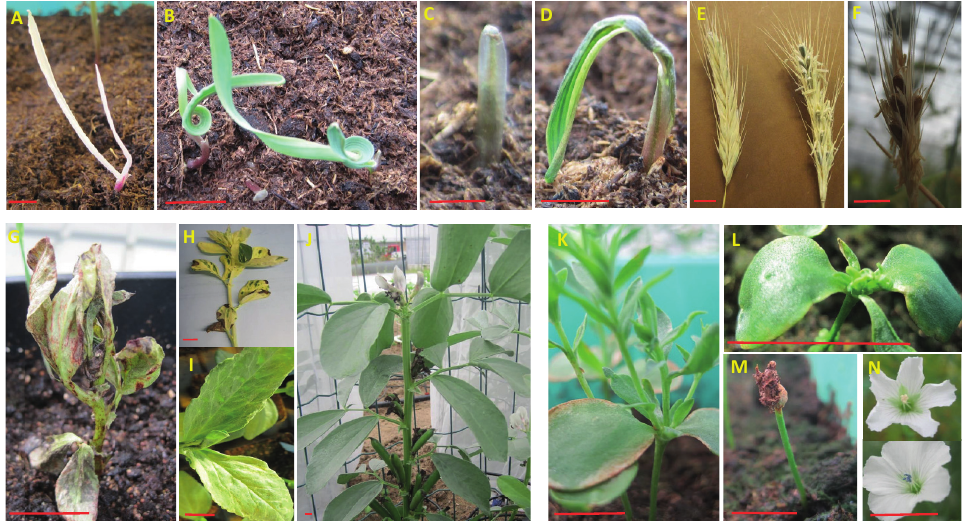
Fig. 3. Variation in phenotypes of M and M seedlings produced by ion beam irradiation in studied species. (A) 1 2 albino plant of rye; (B) curly leaf in rye; (C) coleoptile mutant in rye; (D) first leaf stunt growth in rye; (E) control (left) vs mutant (right), naked spike in rye; (F) mutant spike of rye; (G) rusty leaves in faba bean; (H) sectional chimera leaf in faba bean at M ; (I) Maculata leaflet in faba bean at M ; (J) terminal inflorescence mutation in 2 2 faba bean which was observed at M and M ; (K) multi-branching linseed seedling; (L) foliage leaves showing early 1 2 damage in linseed; (M) early damage in linseed; (N) pollen diversity in linseed; bar = 1